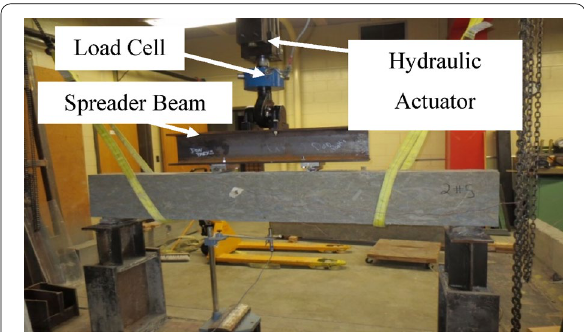
Fig. 3 Testing setup for beam specimen.